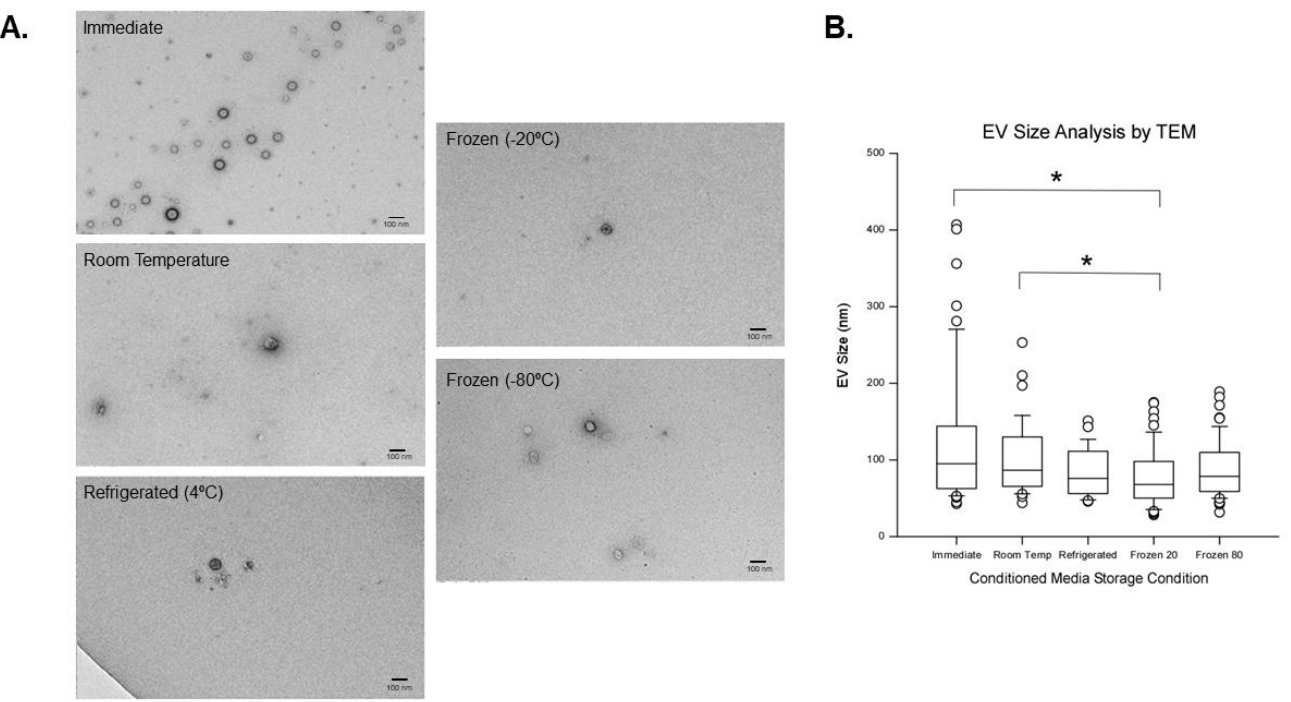
Figure 5. Transmission electron microscopy (TEM) analysis of extracellular vesicles (EVs). ( A ) TEM micrographs depicting EVs from all experimental groups that are roughly spherical ranging in diameter from 67.9–95.0 nm. Note that the morphology of EVs in the immediate group are similar to those in the -80 °C group with the distinct black ring (doughnut shape) indicating a bilayer structure. The calibration bar in micrographs is 100 nm. ( B ) TEM estimate of EV size. Significant differences were observed between EVs in the immediate group and -20 °C ( p = 0.002) and between EVs in the room temperature group and − 20 °C ( p = 0.045). Data are presented as the median, 25th, and the 75th percentile in the box and whiskers show the 10th and 90th percentile. Potential outliers are depicted as open circles. Asterisk depicts significant difference ( p -value < 0.05).